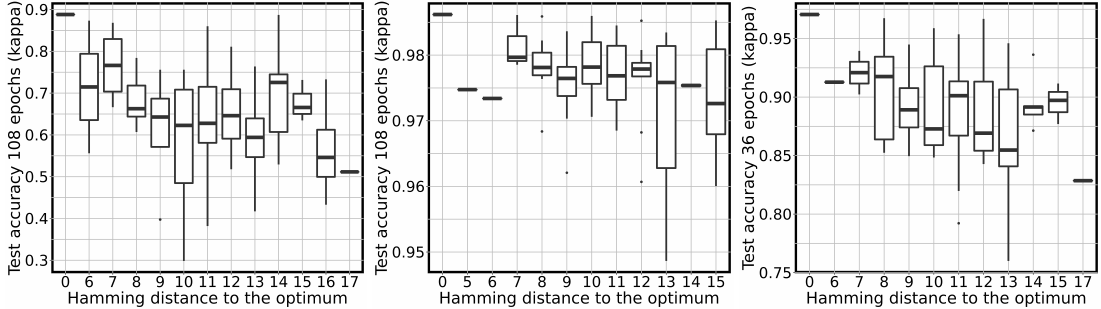
Figure 8. Fitness distance correlation after 108 epochs of training. From left to right are shown results using Sentinel-1, Sentinel-2 and both sensors.